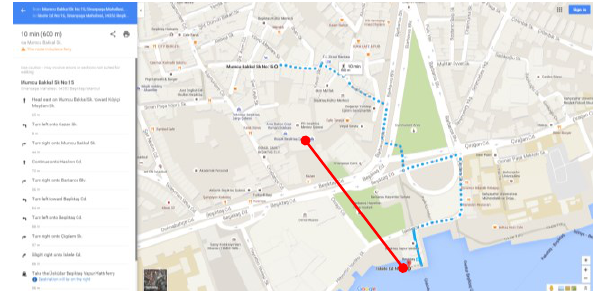
Figure 12. Pedestrian Travel Path Navigation within